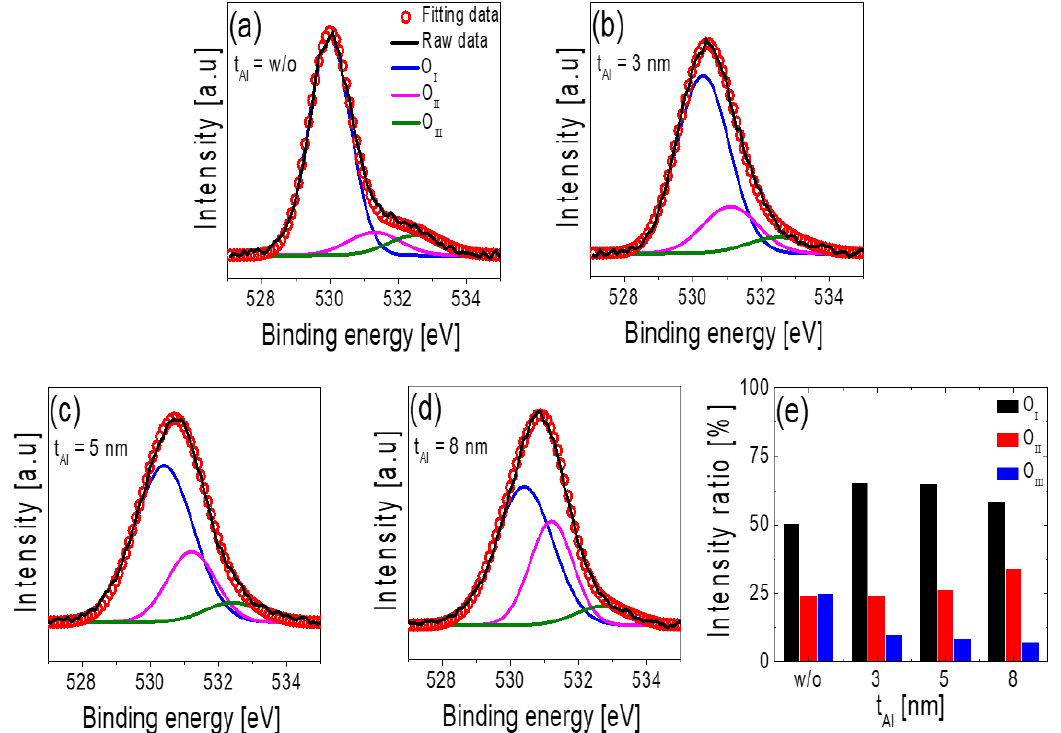
Figure 5. X-ray photoelectron spectroscopy (XPS) O1s spectra of the IGTO thin films ( a ) without and with ( b ) 3, ( c ) 5, and ( d ) 8 nm thick Al capping layers, obtained at the middle of the thin films. ( e ) Relative areas of each peak corresponding to O I (metal–oxygen lattice), O II (oxygen deficiencies), and O III (weakly bonded oxygens), obtained from the IGTO thin films without and with 3, 5, and 8 nm thick Al capping layers.